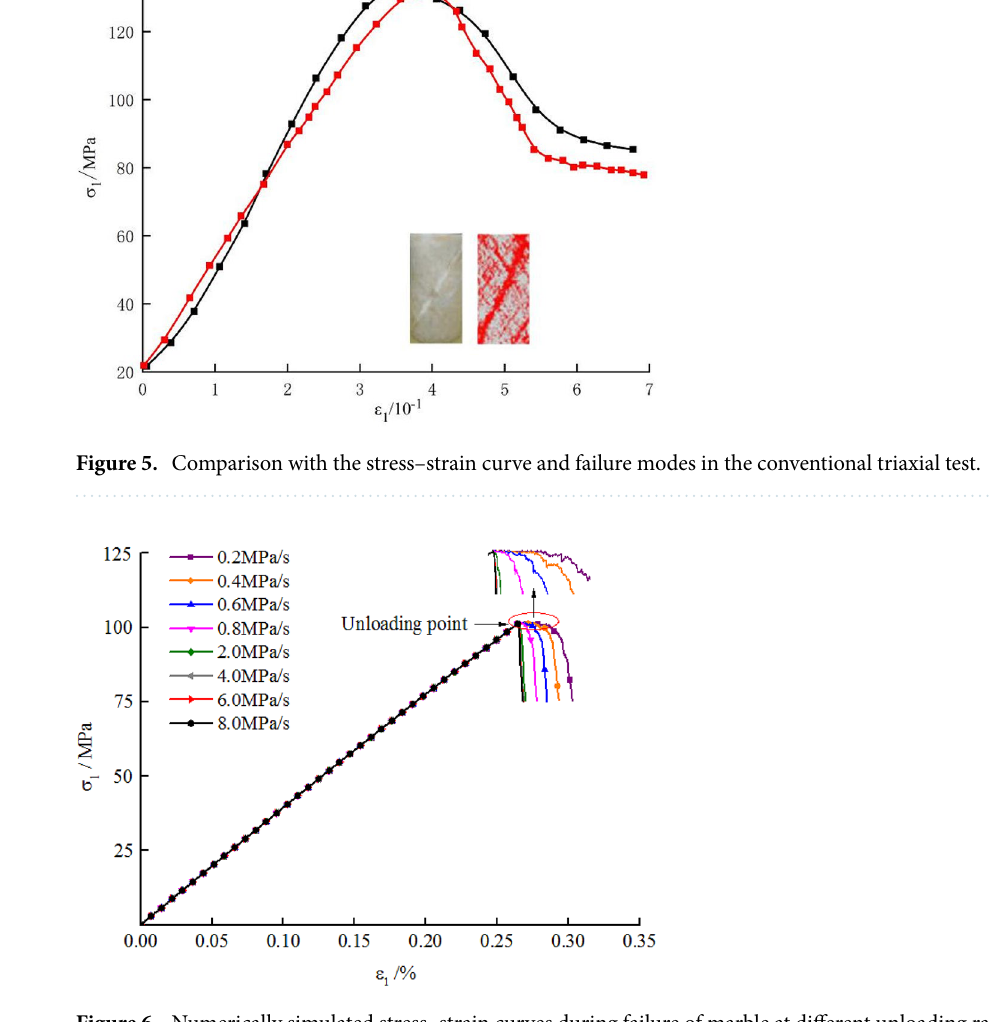
Figure 6. Numerically simulated stress–strain curves during failure of marble at different unloading